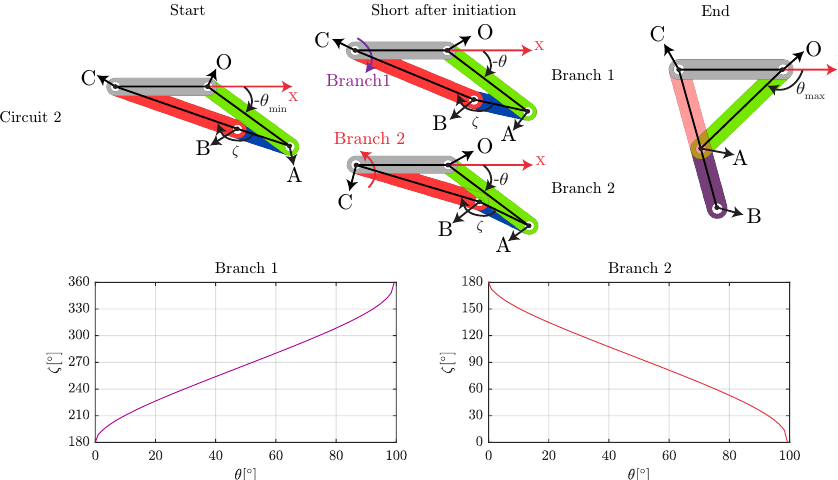
Figure 10. The second circuit of this specific four-bar design indicates that another circuit entails an entirely different range. Nonetheless, the circuit is also constructed by two connected branches with the same transition conditions for ζ